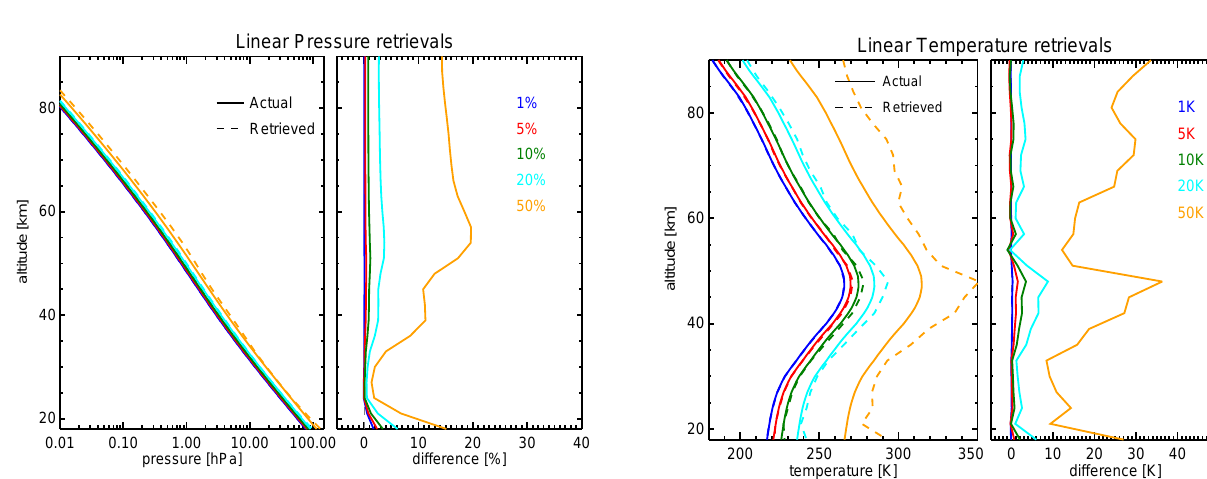
the other gases are already accurately